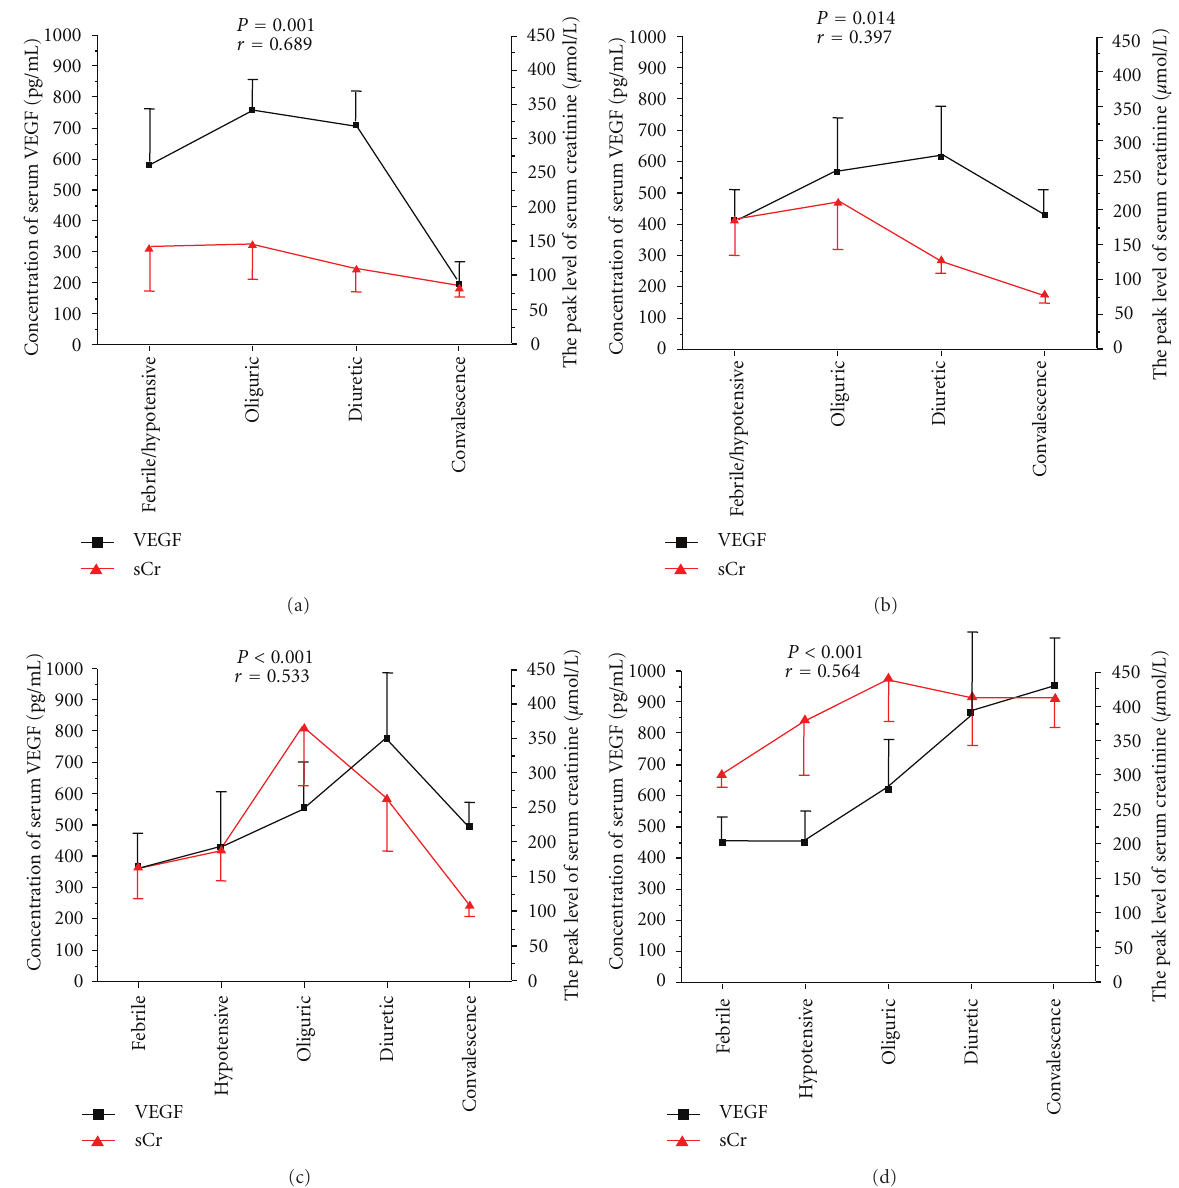
Figure 3: The correlation between the mean level of serum VEGF and the mean level of serum creatinine in four di ff erent severity groups at each stage of HFRS. (a) Mild patients, (b) moderate patients, (c) severe patients, and (d) critical patients were investigated. The nonparametric Spearman correlation analysis was used to evaluate the r and P values. sCr: serum